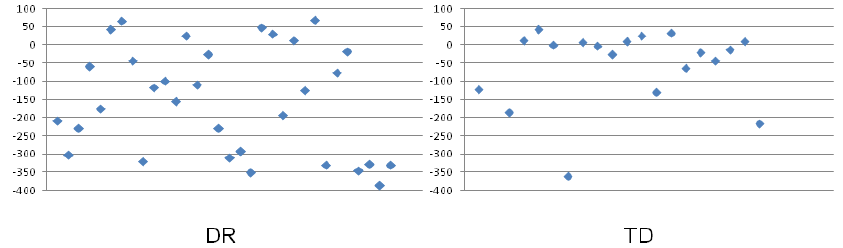
Figure 6. Scatter plots showing the mean EEs for all numbers used in the 0–1000 verbal task calculated for each participant. The results obtained in the DR group are presented on the ( left ), and the results obtained in the TD group are on the ( right ).